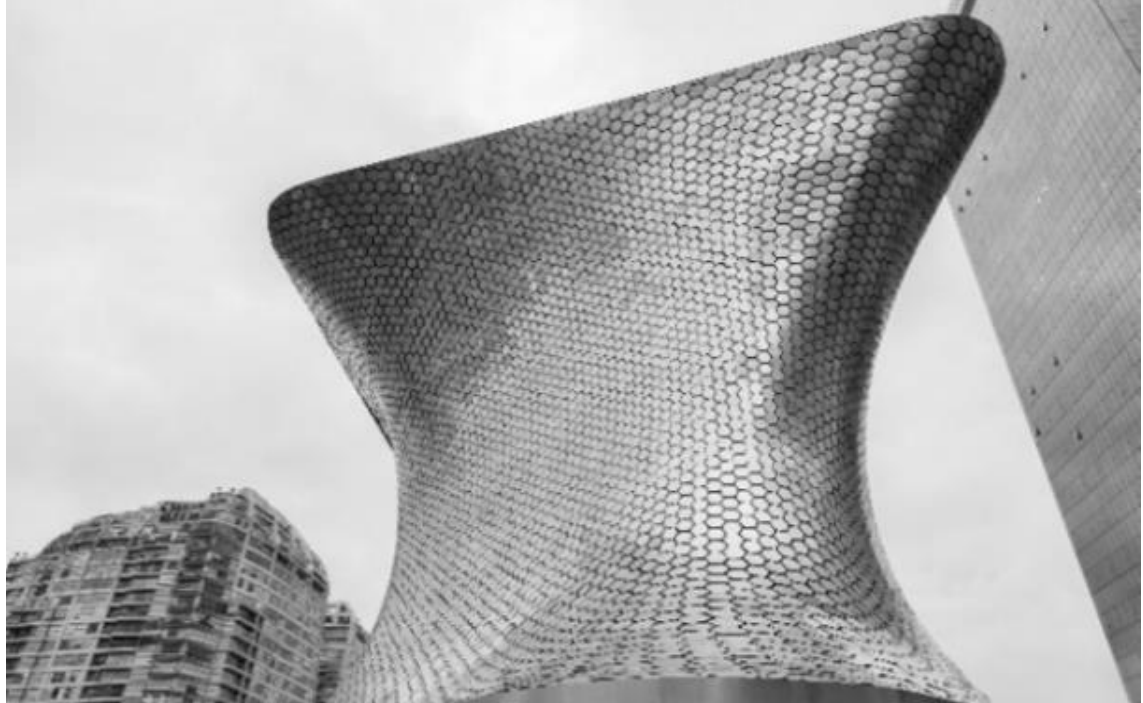
Figure 5 – Museo Soumaya – Source: Diego Delso,